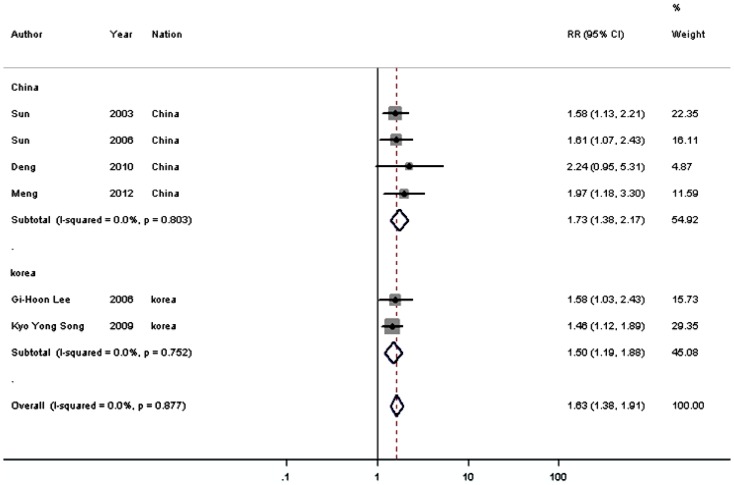
Meta-analysis on the relation between Survivin expression and 5-year overall survival (OS).The summary RR and 95% CIs were shown (fixed-effect model analysis).